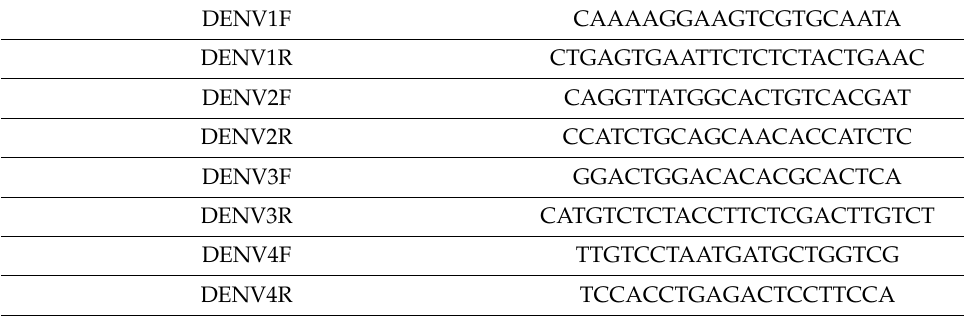
Table 1. CDC DENV1-4 RT-PCR primer sequences (5 (cid:48) –3 (cid:48)